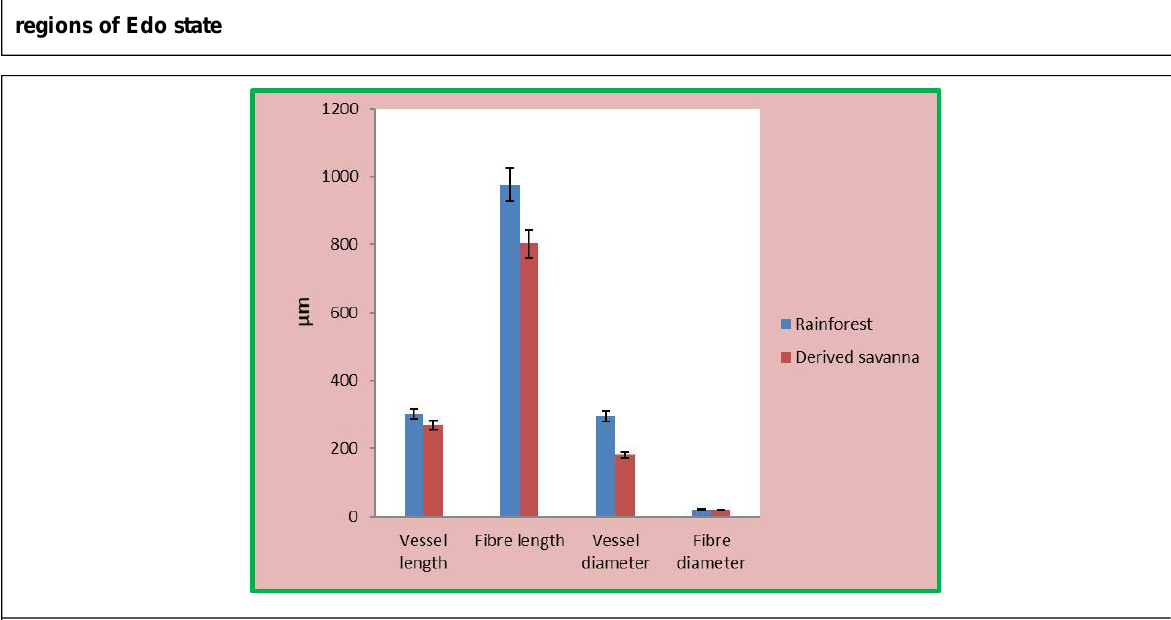
Figure 2: Vessel and fiber lengths and diameters of L. cupanoides growing in the rainforest and derived savanna regions of Edo